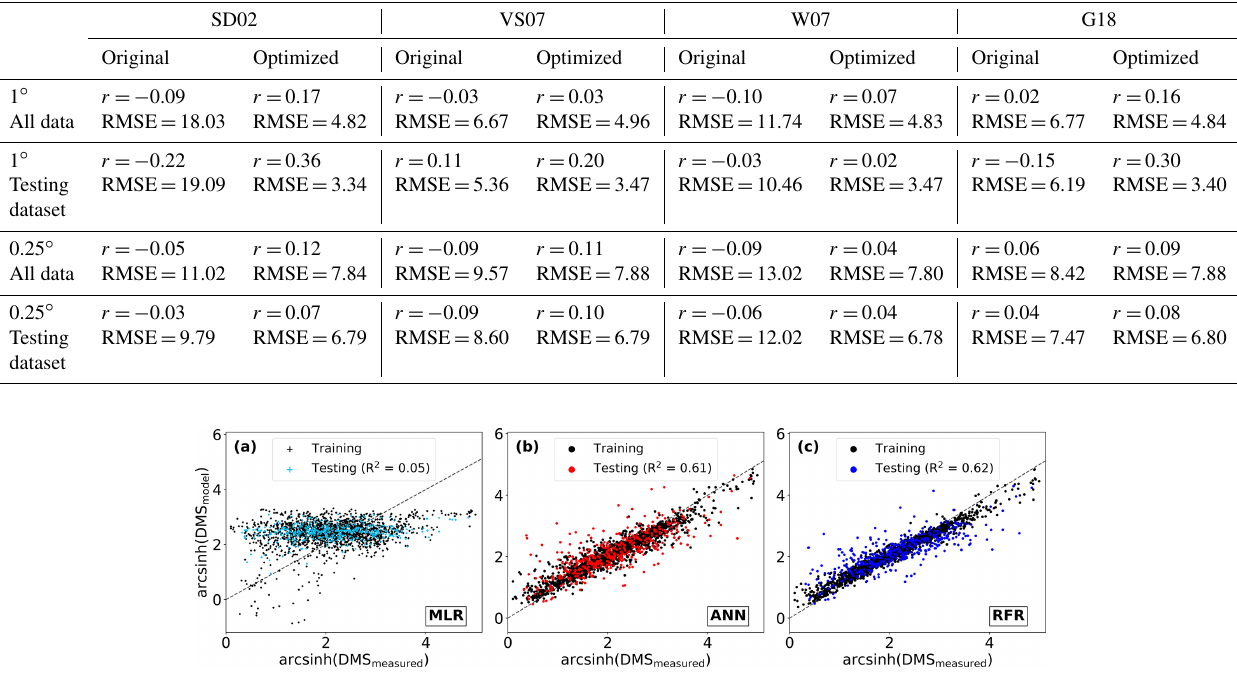
Figure 3. Performance of three modelling approaches in predicting observed DMS distributions: (a) multiple linear regression (MLR), (b) ensemble of artificial neural networks (ANN), and (c) ensemble of random forest regression (RFR). For consistency, all predictions are partitioned by the training and testing datasets used to build the ensembles (see Sect. 2.2). Model performance ( R 2 ) is computed only for the testing dataset predictions. The dashed line demonstrates a 1:1 relationship. Modelled DMS concentrations depicted range from 0.4 to 84.3 (RFR, nM) and 0.3 to 74.6 (ANN,